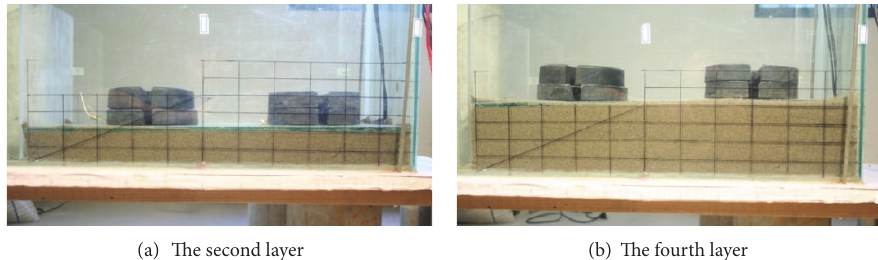
Figure 3: Weight applied to let the soil settle.